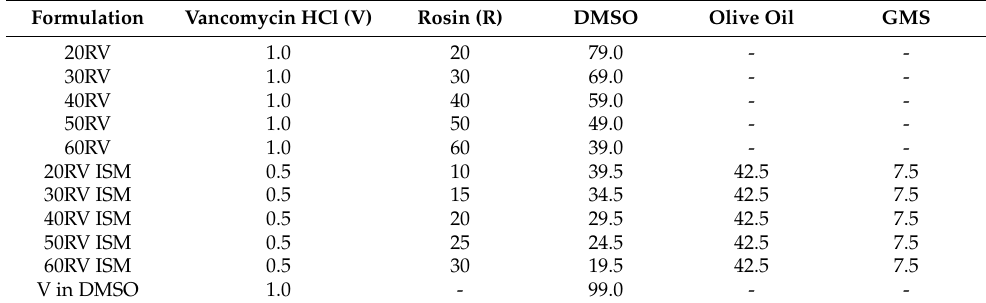
Table 1. Composition of vancomycin HCl-loaded rosin-based ISG and ISM formulations.